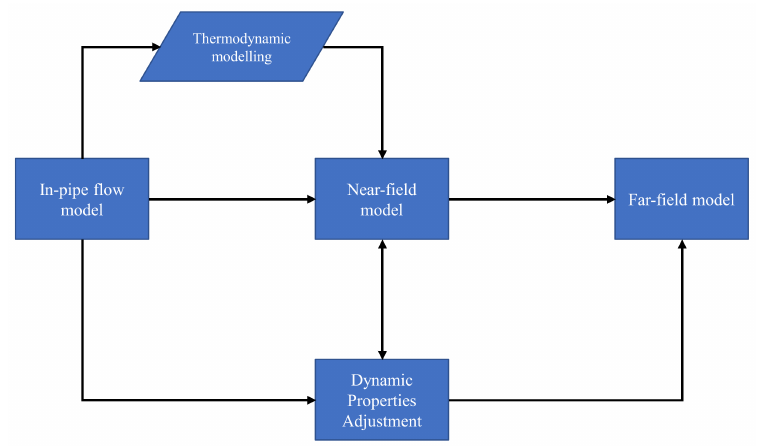
Figure 5. Integrated thermo-physical modeling